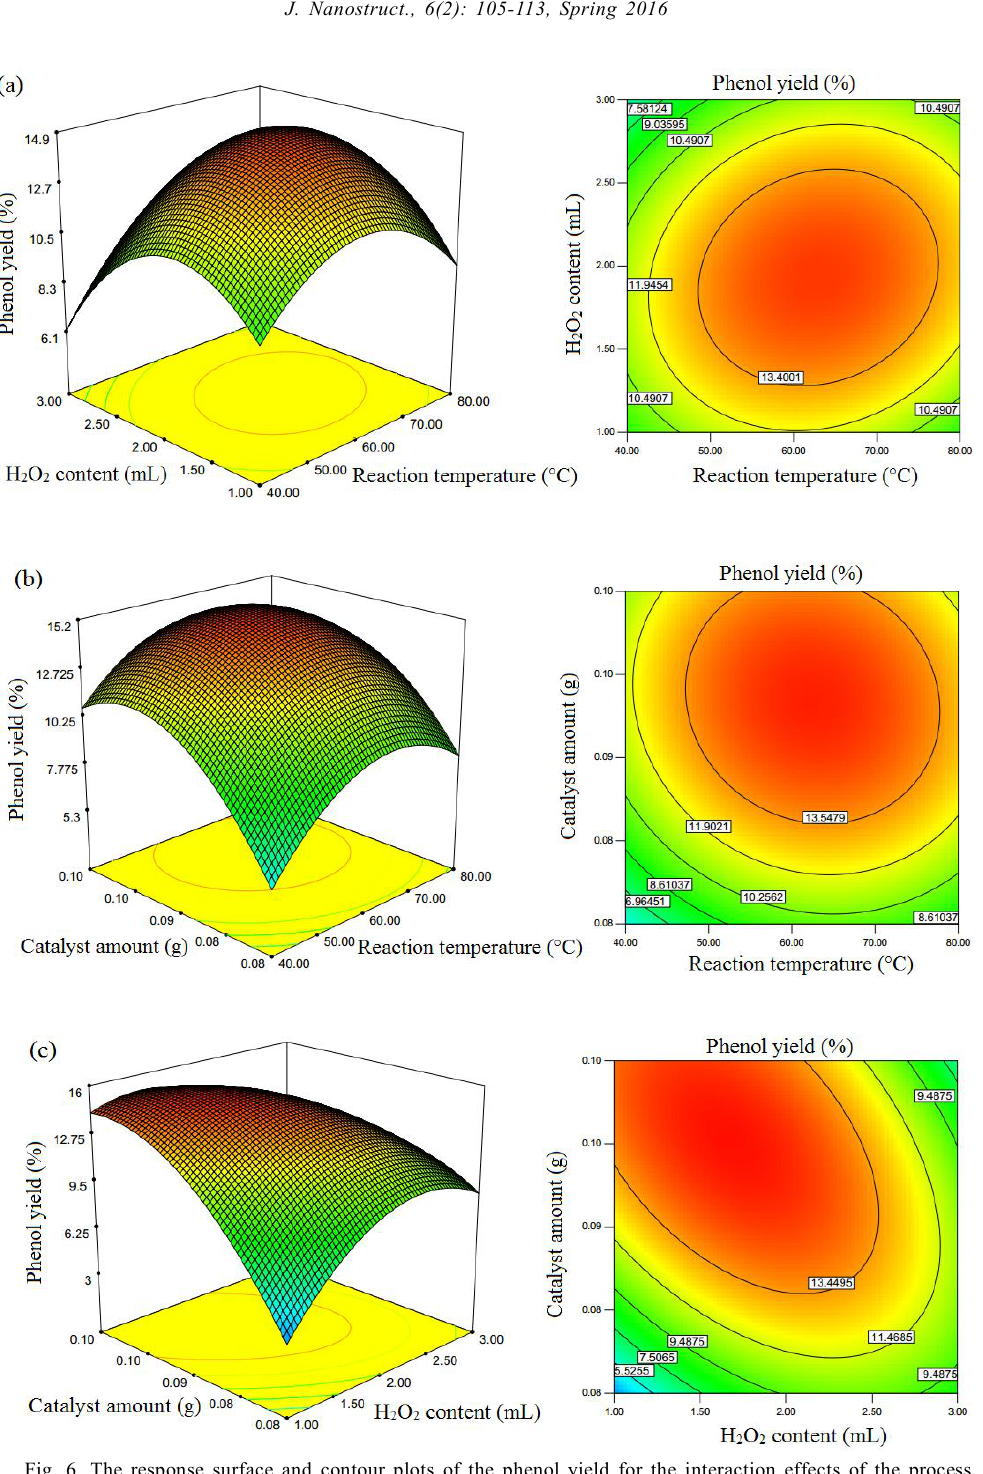
Fig. 6. The response surface and contour plots of the phenol yield for the interaction effects of the process variables. (a) reaction temperature with